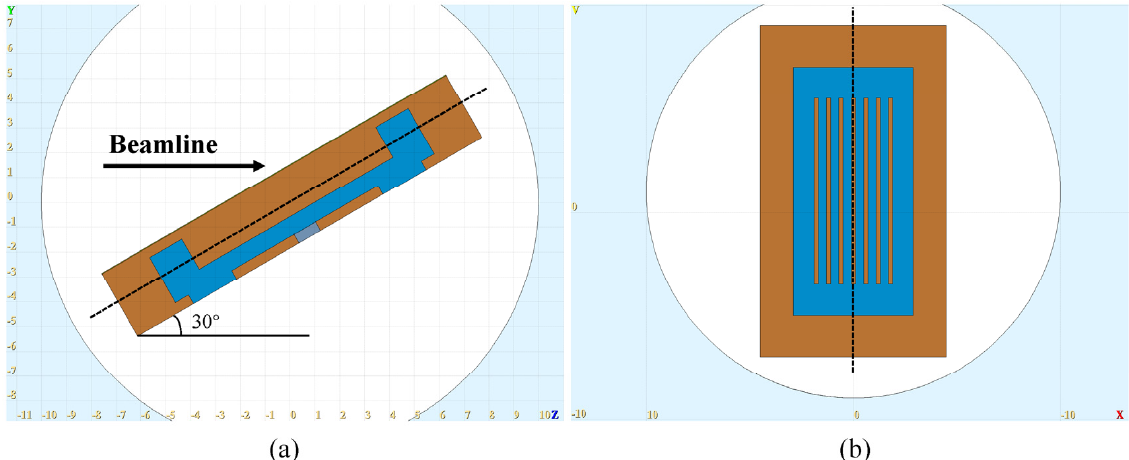
Figure 3. Target geometry: ( a ) side view section and ( b ) top view section. Distances are given in cm.